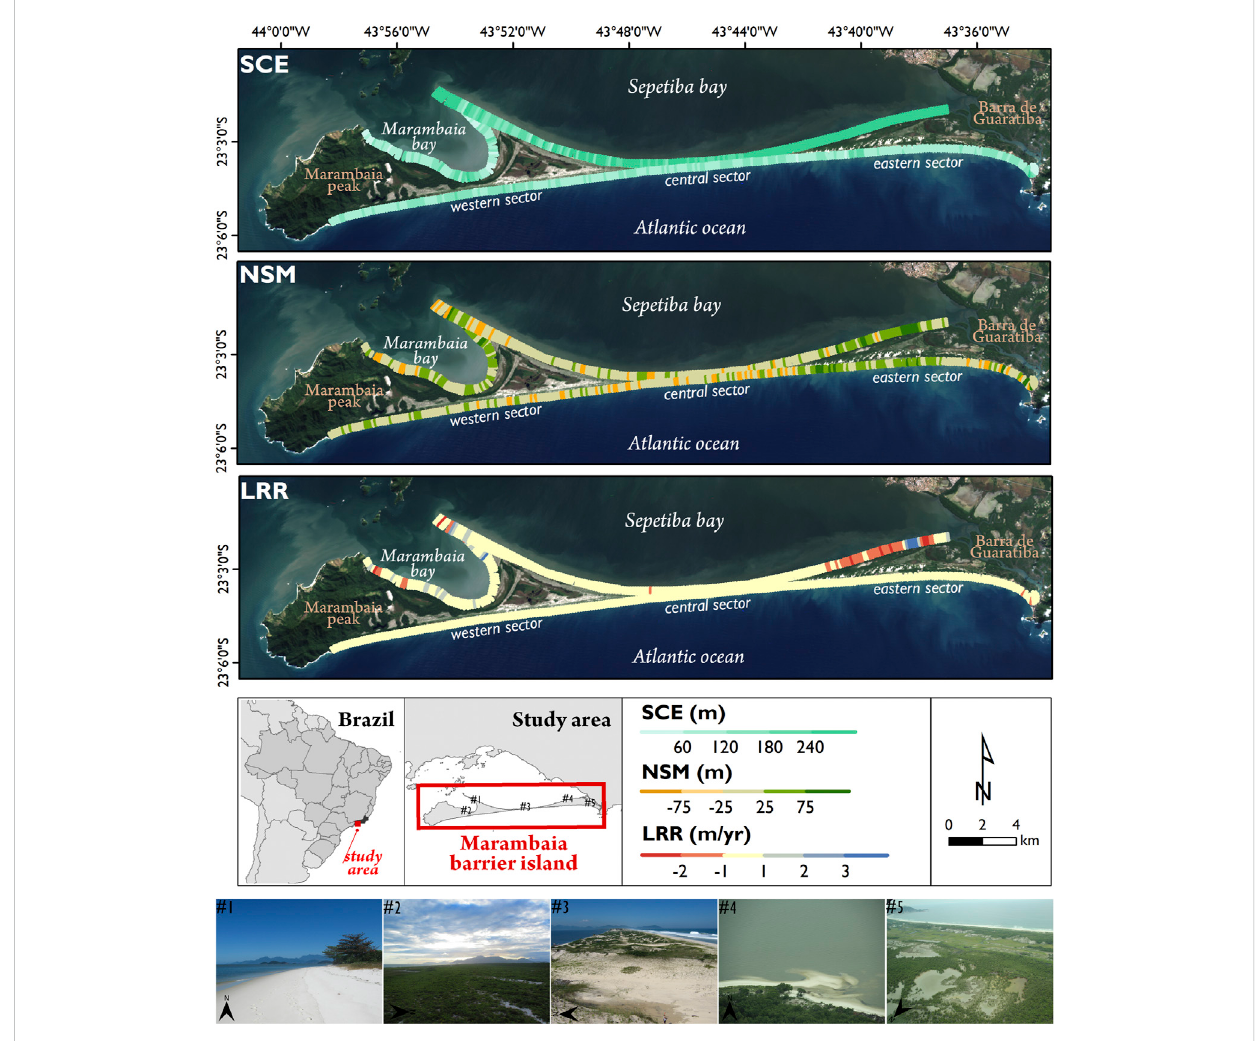
FIGURE 1 Marambaia barrier island location. SCE, shoreline change envelope; NSM, net shoreline movement; LRR, linear regression rate. Landsat 8 satellite imagery from 05/Jun/2021, 4R3G2B composition.